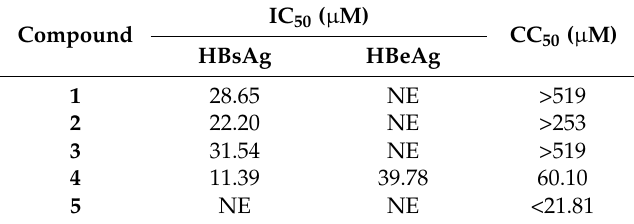
Table 2. Anti- hepatitis b virus (HBV) activity and cell proliferation of five